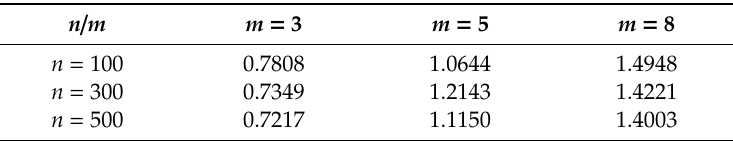
Table 6. GAPs of SPT-DA heuristic.